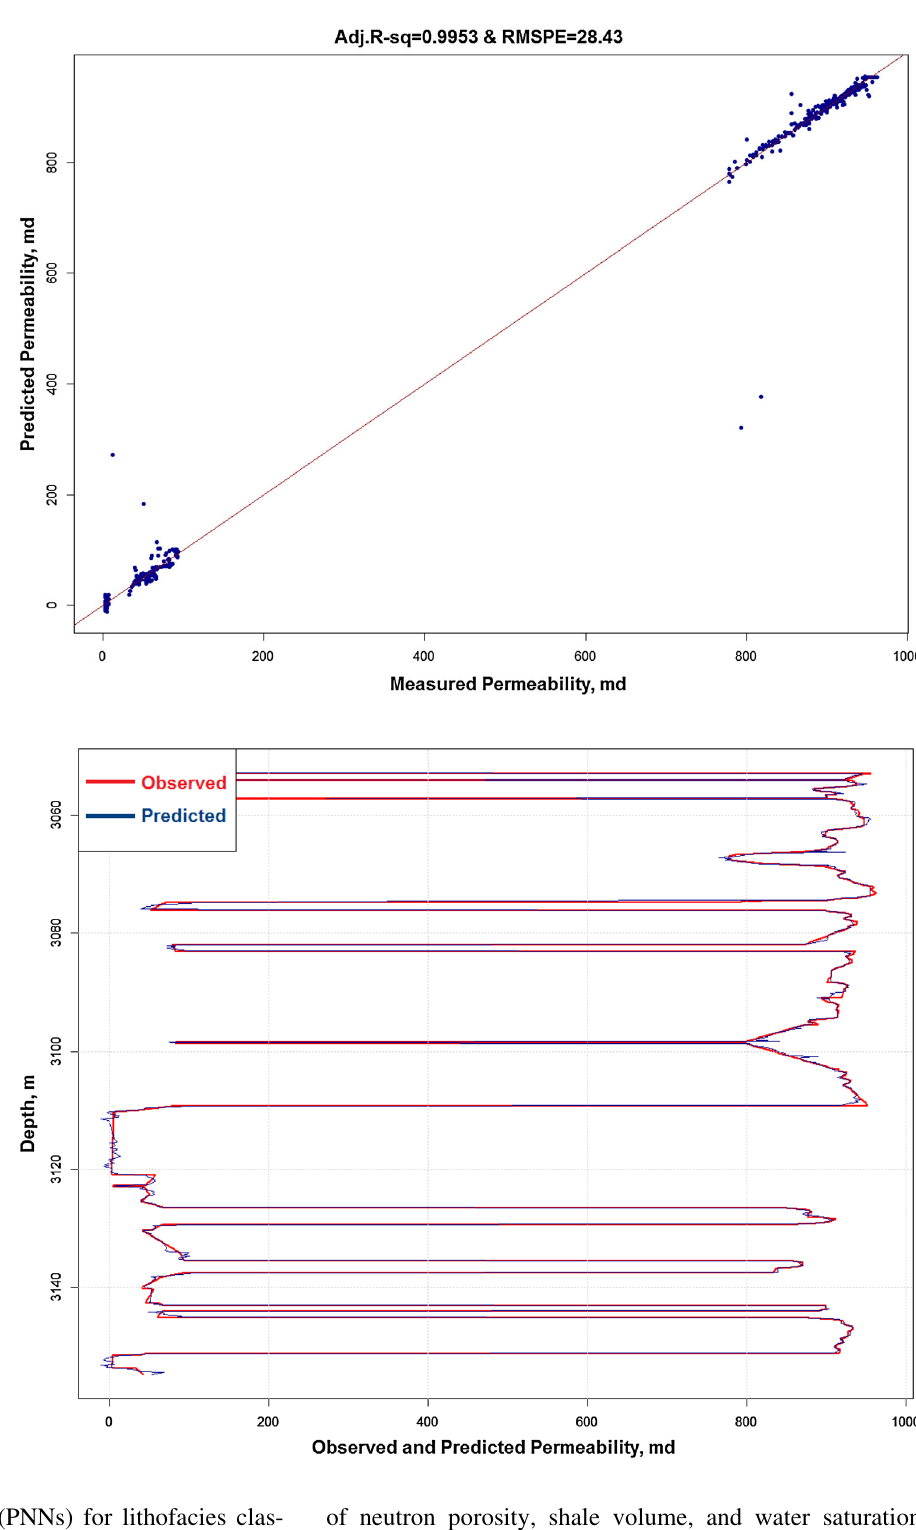
Fig. 7 Scatterplot of predicted and observed core permeability given the testing subset by GBM algorithm